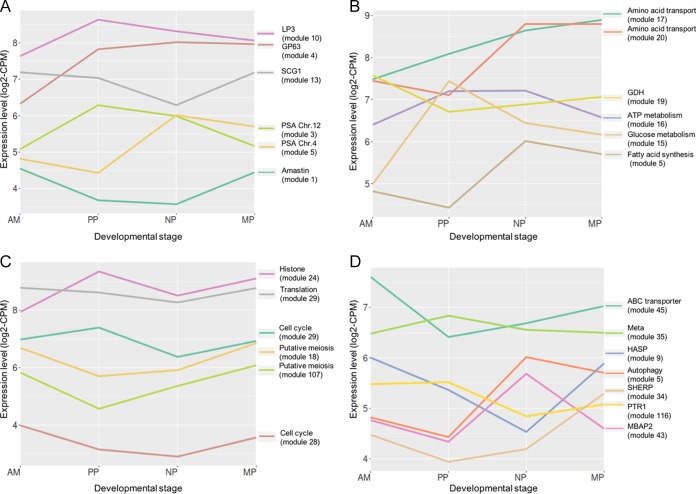
Selected coexpression modules showing dynamics of cellular processes across L. major developmental stages in the sand fly. Each line represents a plot of the median expression level of a selected gene or group of genes in coexpression modules relating to cell surface (A), metabolism (B), cell cycle and gene expression (C), and differentiation, stress, and autophagy (D). Values shown are the log2 counts per million and represent the proportion of reads mapped to each Leishmania gene, multiplied by 106.